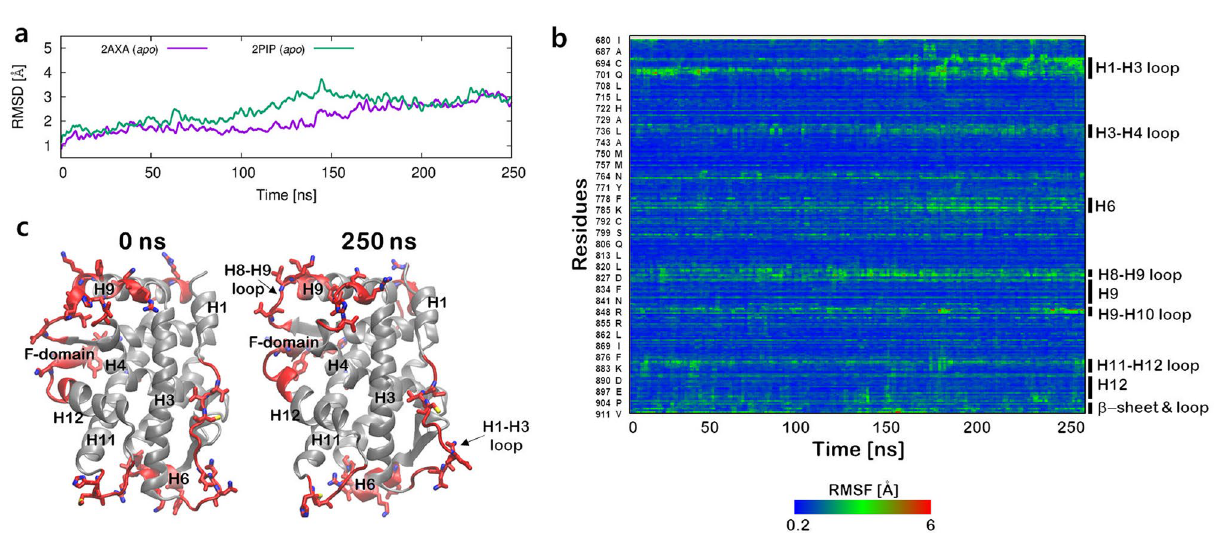
Figure 2. Conformational changes of apo AR during 250 ns aMD simulations. ( a ) The backbone RMSD. ( b ) RMSF analysis. ( c ) The comparison of the initial X-ray crystal structure of the AR (PDB ID: 2AXA) after removal of the ligand (S1) and the resulting structure after 250 ns aMD simulation. The regions showing RMSF > 2.5 Å are colored in red. Images were created by using VMD v1.9.3, plugin 52 and Gnuplot v5.2 57